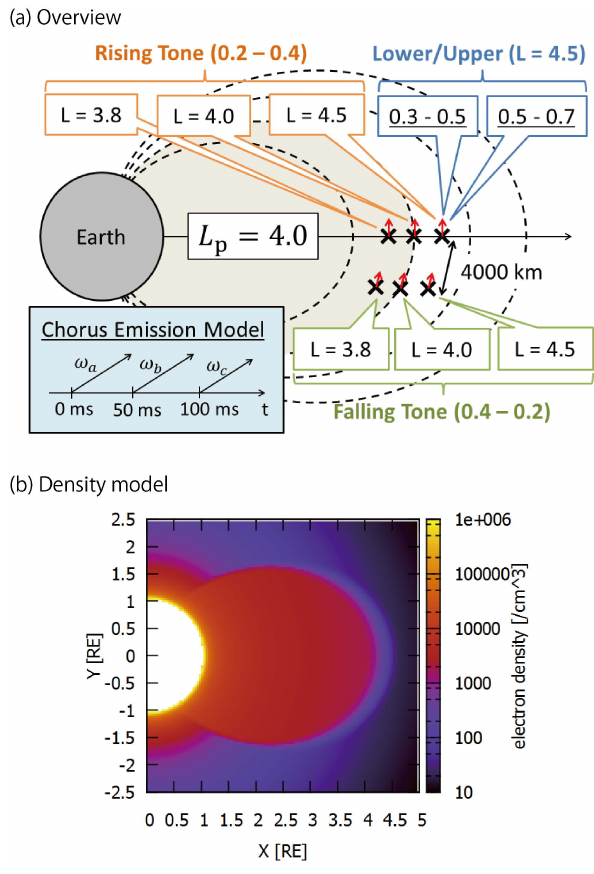
Fig. 1. (a) Meridional plane cross section of the magnetosphere in- dicating the plasmapause and the starting positions of the ray trac- ing. (b) Diffusive equilibrium model for cold plasma density.